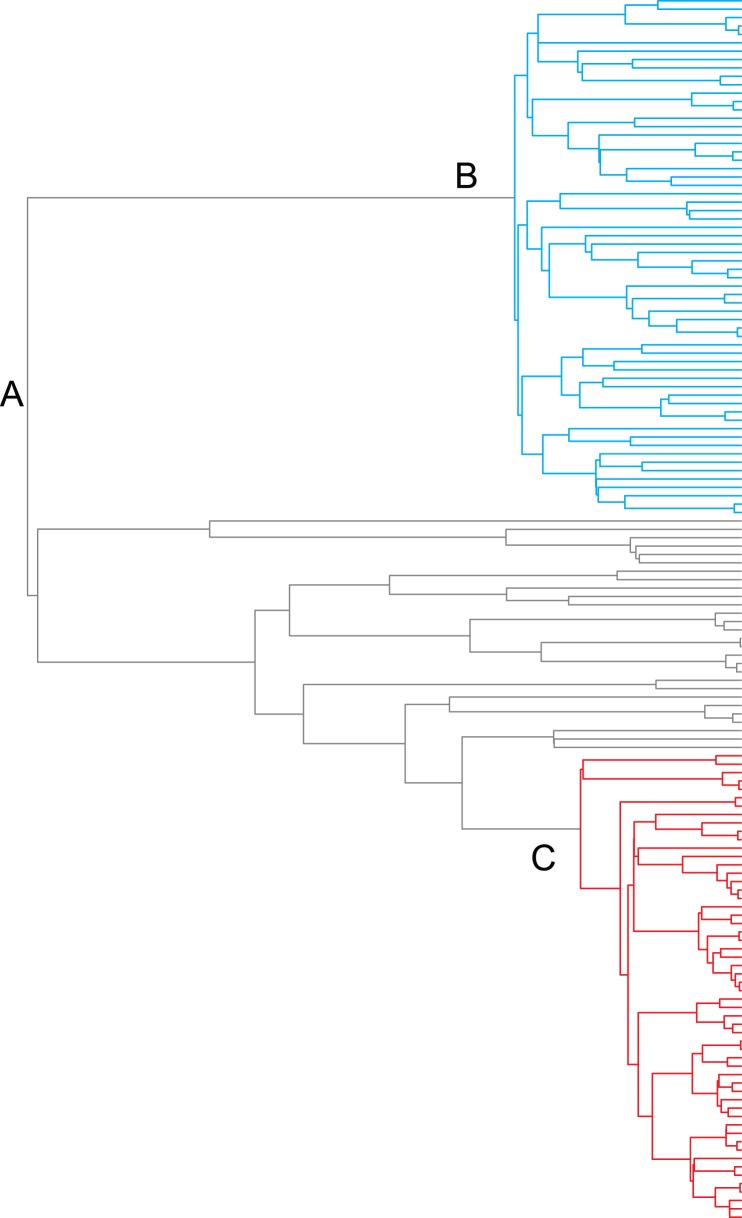
Example of tree simulated under mixture of three distinct evolutionary processes.(A) Clade diversification under constant-rate “background” diversification process with λ = 0.032 and μ = 0. (B) Shift to new adaptive zone with subsequent diversity-dependent regulation of speciation and diversity-independent extinction (blue branches; λ0 = 0.395; K = 66; μ = 0.041). (C) Another lineage shifts to diversity-dependent speciation regime (red branches; λ0 = 0.21; K = 97; μ = 0.012). Total tree depth is 100 time units. Despite undergoing two distinct diversity-dependent slowdowns in the rate of speciation, the overall gamma statistic [63] for the tree is positive (γ = 2.51) and provides no evidence for changes in the rate of speciation through time. Note that a tree with three distinct processes contains two distinct transitions between processes.